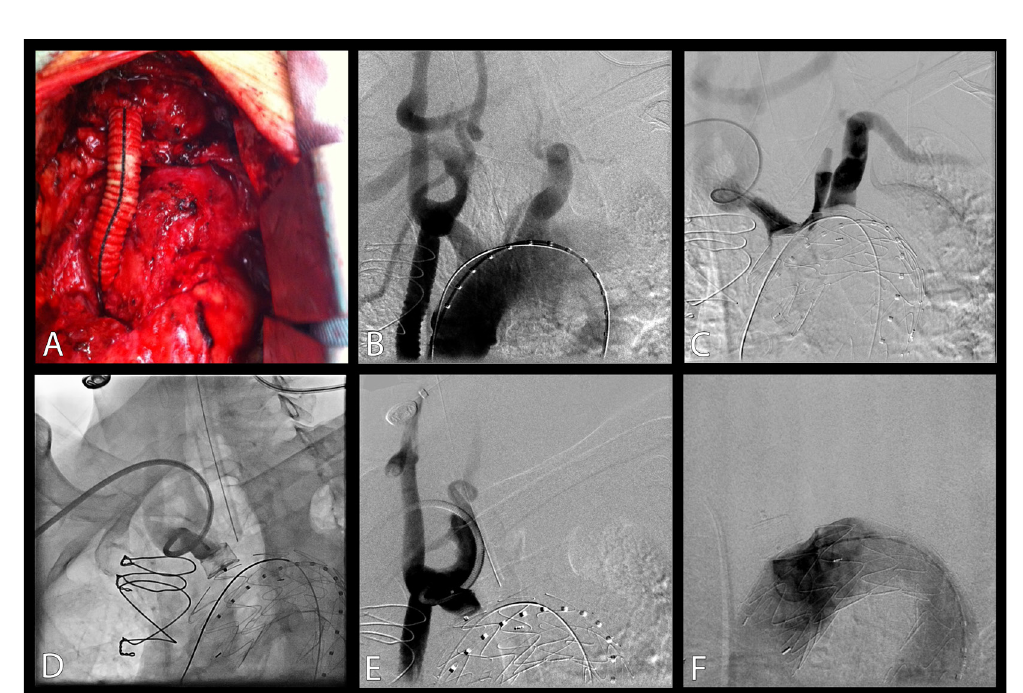
Fig. 5 - Brachiocephalic ascending aorta graft associated with carotid-carotid graft placement of vascular plug and aortic endoprosthesis implantation in Zone 0. Intentional occlusion of left subclavian artery. A=Brachiocephalic ascending aorta surgical graft. B=Preoperative arteriography showing patency of brachiocephalic trunk ascending aorta and right-left carotid-carotid artery. C=Stent implantation in Zone 0 and subtraction arteriograph via right subclavian artery demonstrating type 2 leak coming from the brachiocephalic trunk with left subclavian artery filling. D=Implantation of 22 mm vascular plug in the ostium of the brachiocephalic trunk. E=Arteriography control without type 2 leak F=Thoracic aortography without leaks and with disconnection of native supra-aortic